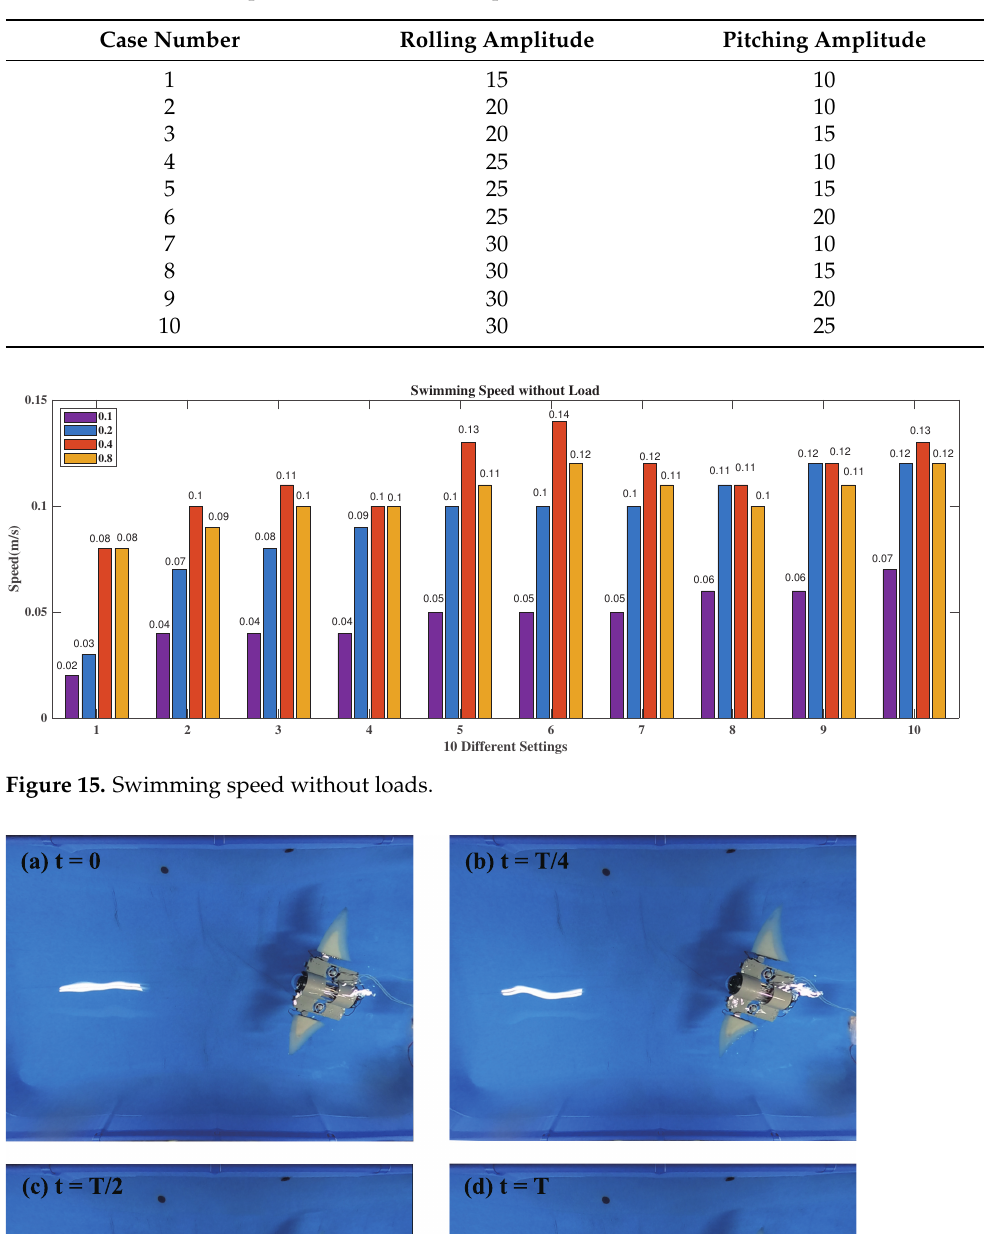
Table 3. The rotation amplitude of 10 different experiments.